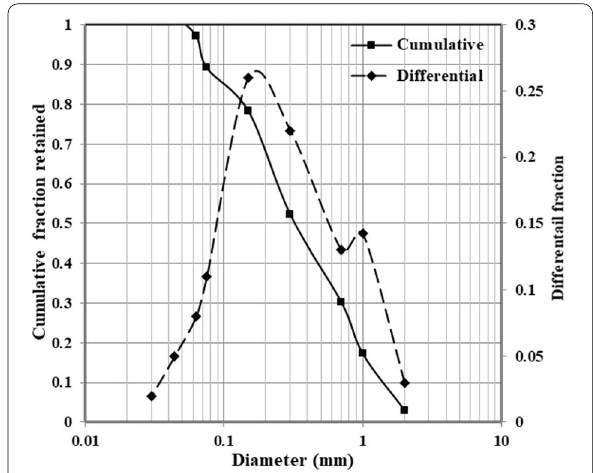
Fig. 4 Particle size distribution of the clay material